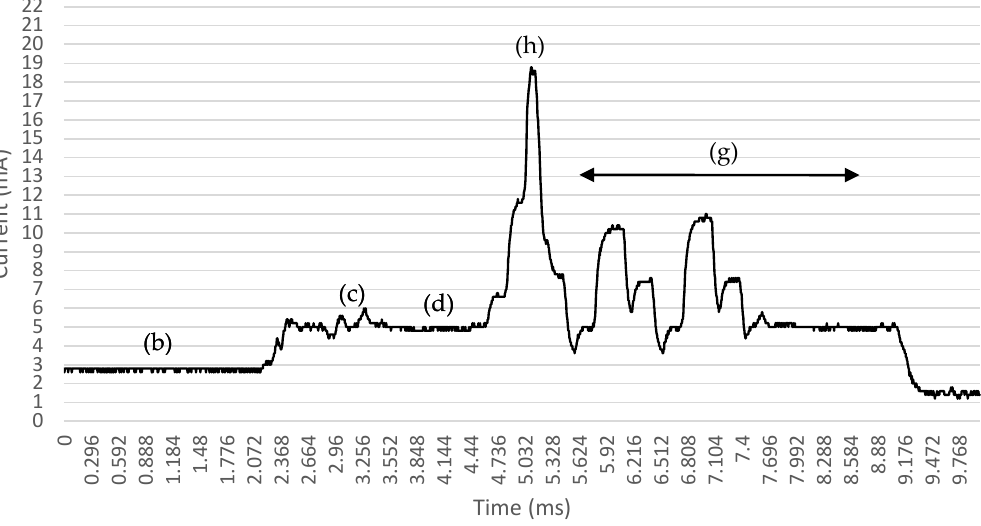
Figure 3. Current profile of just the latter part of the IMU ISR where the BLE ADV process occurs over the same time as the first BLE ADV transmission. Point (h) is now the summation of the SoC current, the FLASH write current, and the BLE ADV transmit current (18.8 mA).